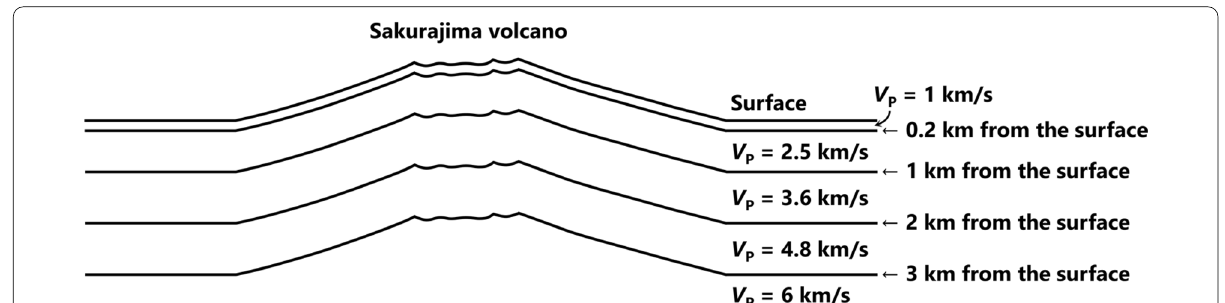
Fig. 10 Schematic description of P-wave velocity structure introduced in the finite element method in "Effect of topography and heterogeneity"